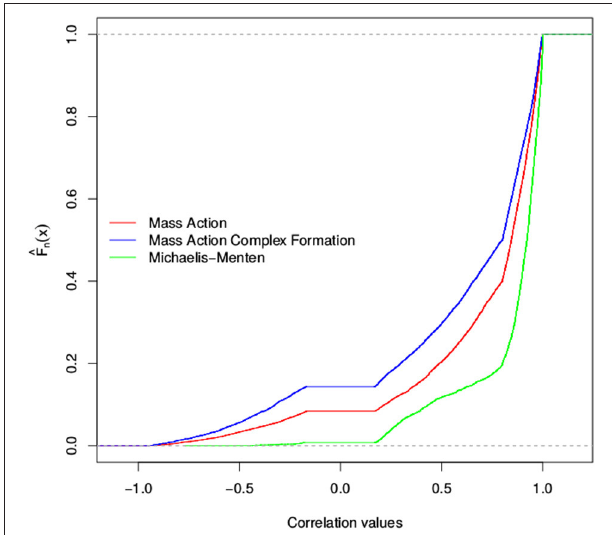
FIGURE 4 | Empirical cumulative distribution function of stoichiometric correlations for three models of the TCA cycle. Shown is the Empirical cumulative distribution of the total number of stoichiometric correlations of simulations of the TCA cycle. The distribution for the mass action simulation is shown in red, the distribution for the substrate-enzyme complex mass action simulation is shown in blue, whereas the Michaelis-Menten simulation is shown in